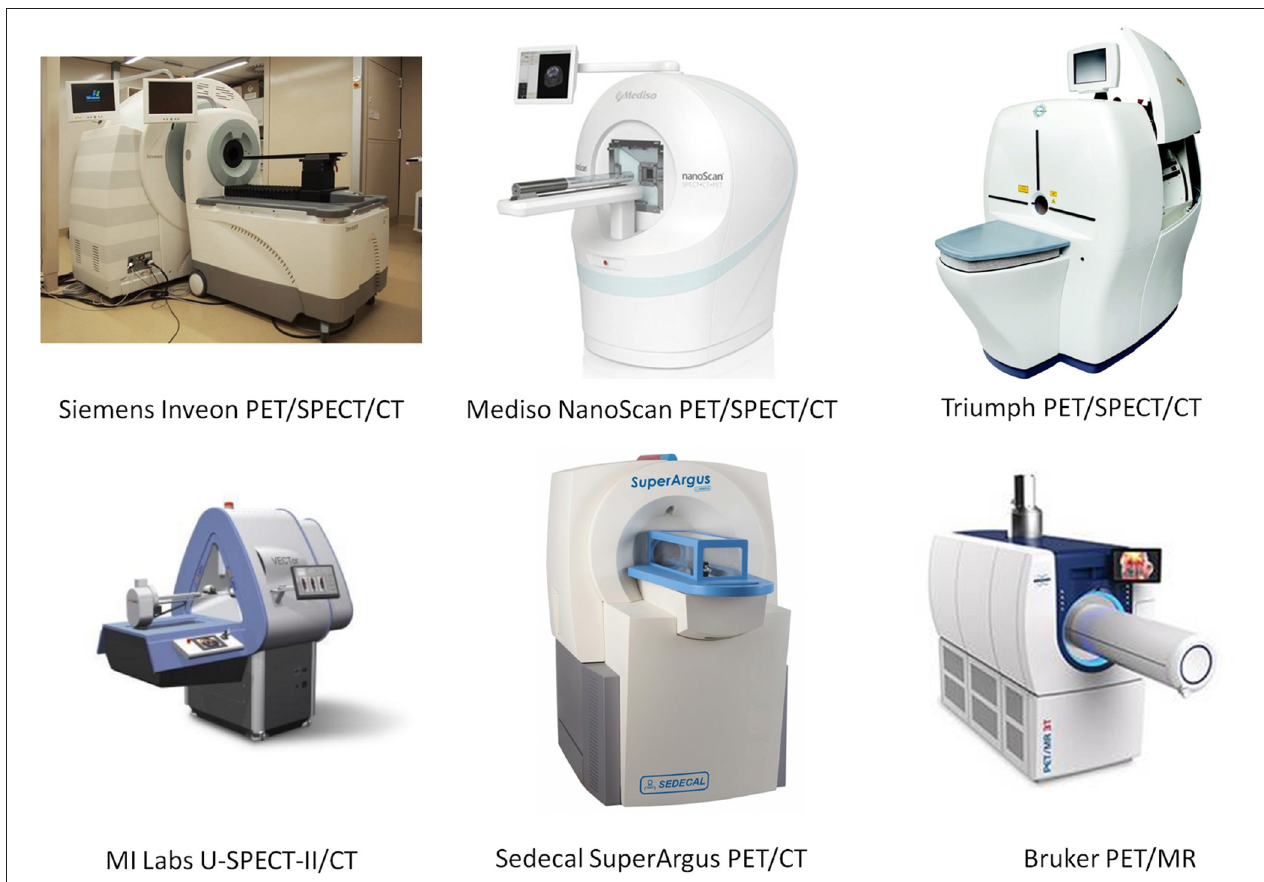
FIGURE 2 | Selected commercially available, dual- and triple-modality preclinical systems. Images taken from vendor’s web pages and published with the permission of the copyright holders (the respective